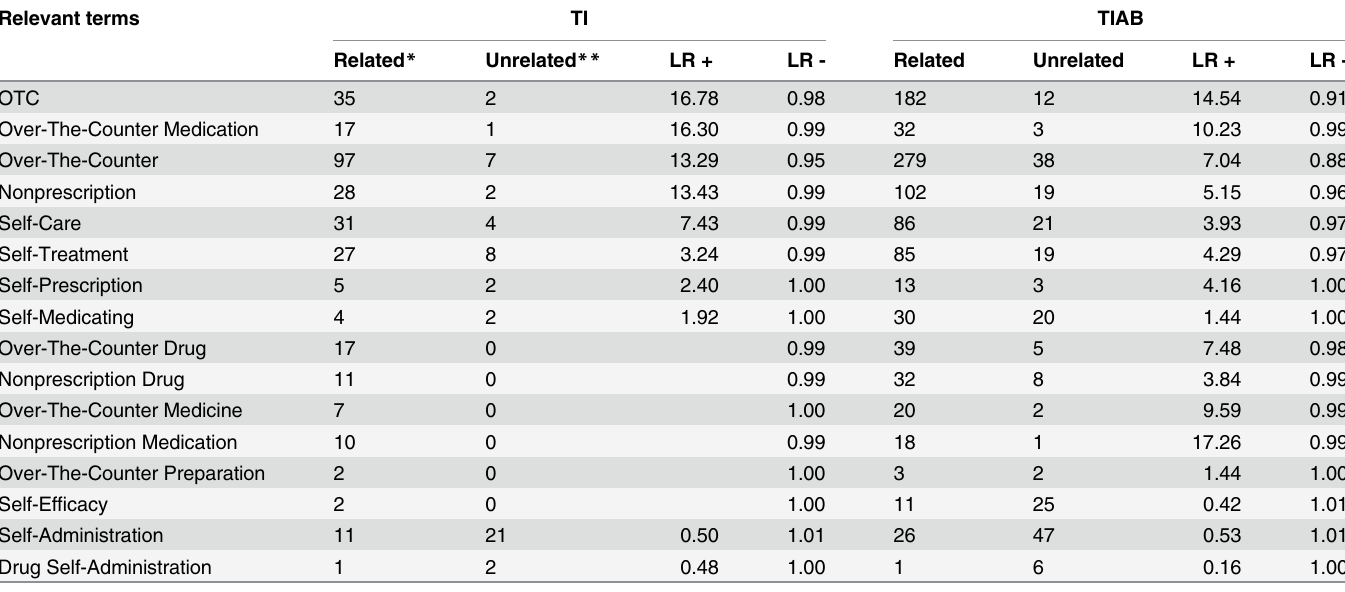
Table 2. LR+ and LR- of relevant terms in TI and TIAB of related and unrelated publications.